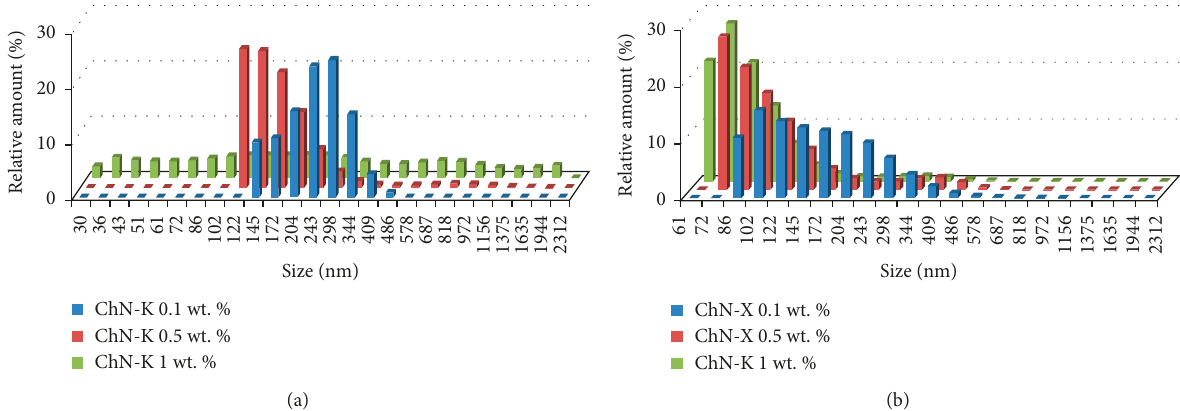
Figure 3: Number-weighted size distribution of ChN-K (a) and ChN-X (b) in their aqueous dispersions at various concentrations.